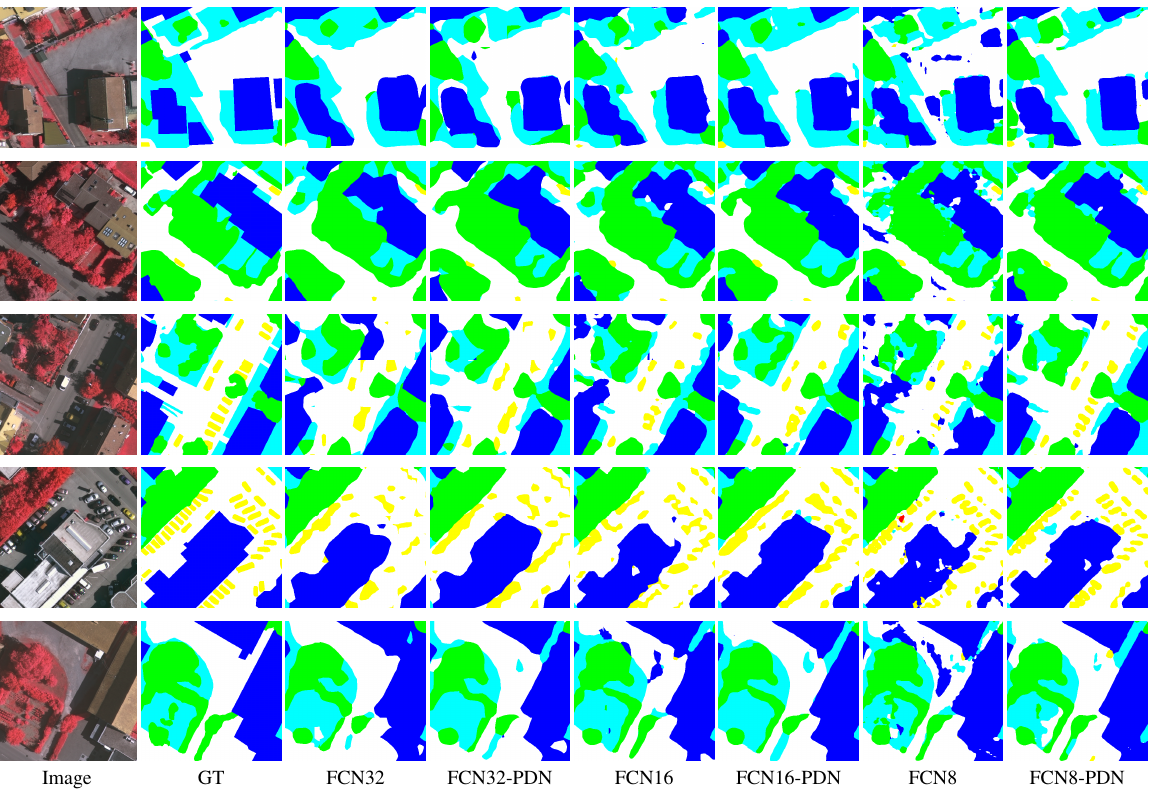
Figure 6. Visualization results on Vaihingen dataset. The first and second columns separately present raw images and their corresponding ground truth labels. The remaining columns show the comparison results with the original FCNs according to the upsampling strides of 32, 16 and 8. Best view in